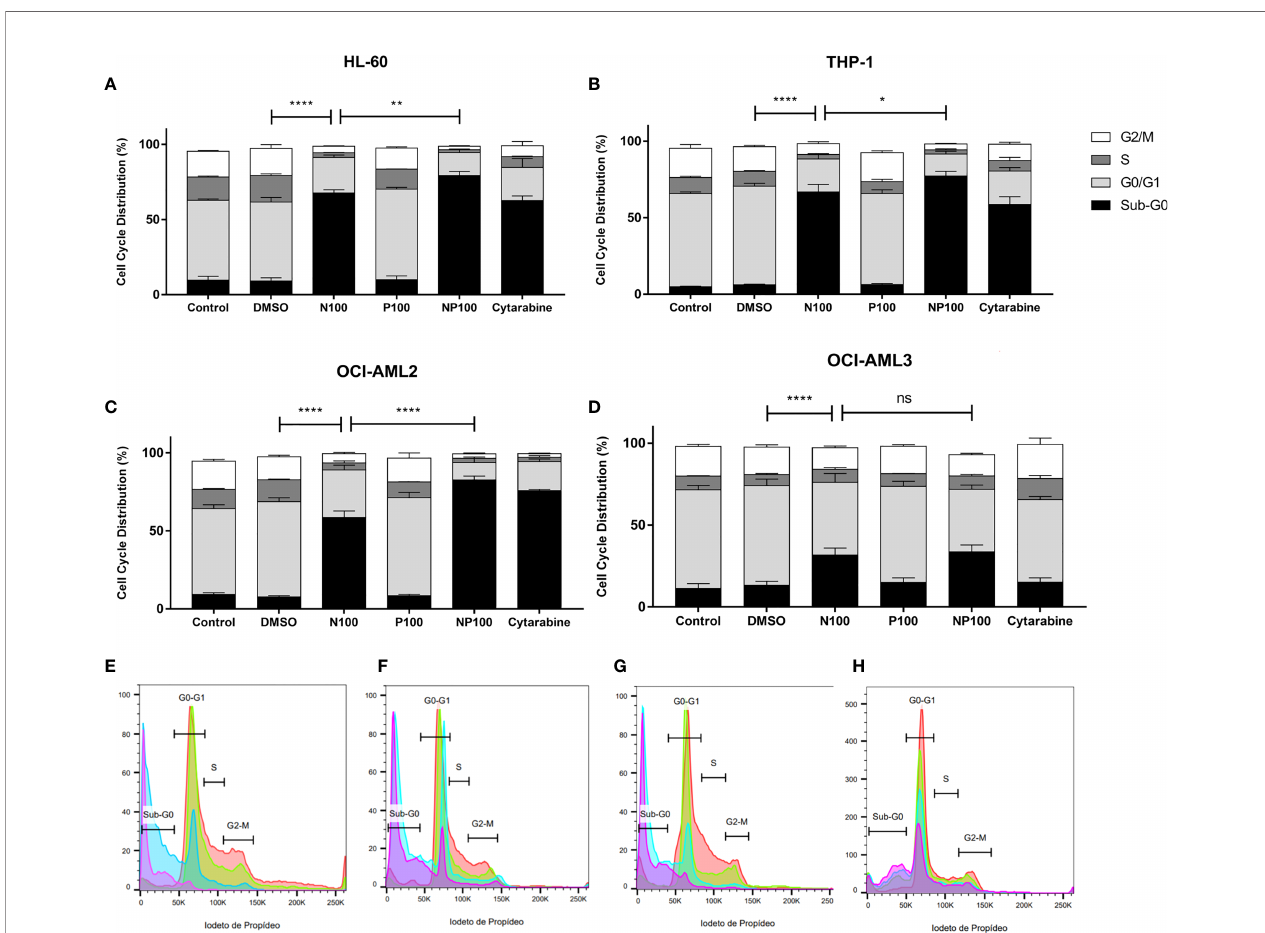
FIGURE 2 | Effect of nimesulide, prednisolone, and cytarabine treatment after 24 h in the cell cycle and death. (A – D) Bar graph showing the percentage of cells in each phase of the cell cycle in HL-60, THP-1, OCI-AML2, and OCI-AML3, respectively. (E – H) Representative histogram of the phases of the cell cycle in HL-60, THP-1, OCI- AML2, and OCI-AML3, respectively. The color red in the histogram represents the non-treatment controls, blue for nimesulide 100 m M of treatment, green for prednisolone 100 m M of treatment, and purple for nimesulide in combination with prednisolone 100 m M. Data shown are representative of 2 independent experiments and presented as mean ± SEM (n = 4). The p-value was determined using the two-way ANOVA multiple comparisons with Turkey ’ s correction, *p < 0.05; **p < 0.01; ****p < 0.001. Control: non-treated cells; DMSO: treated with DMSO (dilution vehicle); N100: nimesulide 100 µM; P100: prednisolone 100 µM; NP100: combination of nimesulide and prednisolone 100 µM; Cytarabine: treated with cytarabine 2.5 µM. DMSO, dimethyl sulfoxide. ns, not signi fi